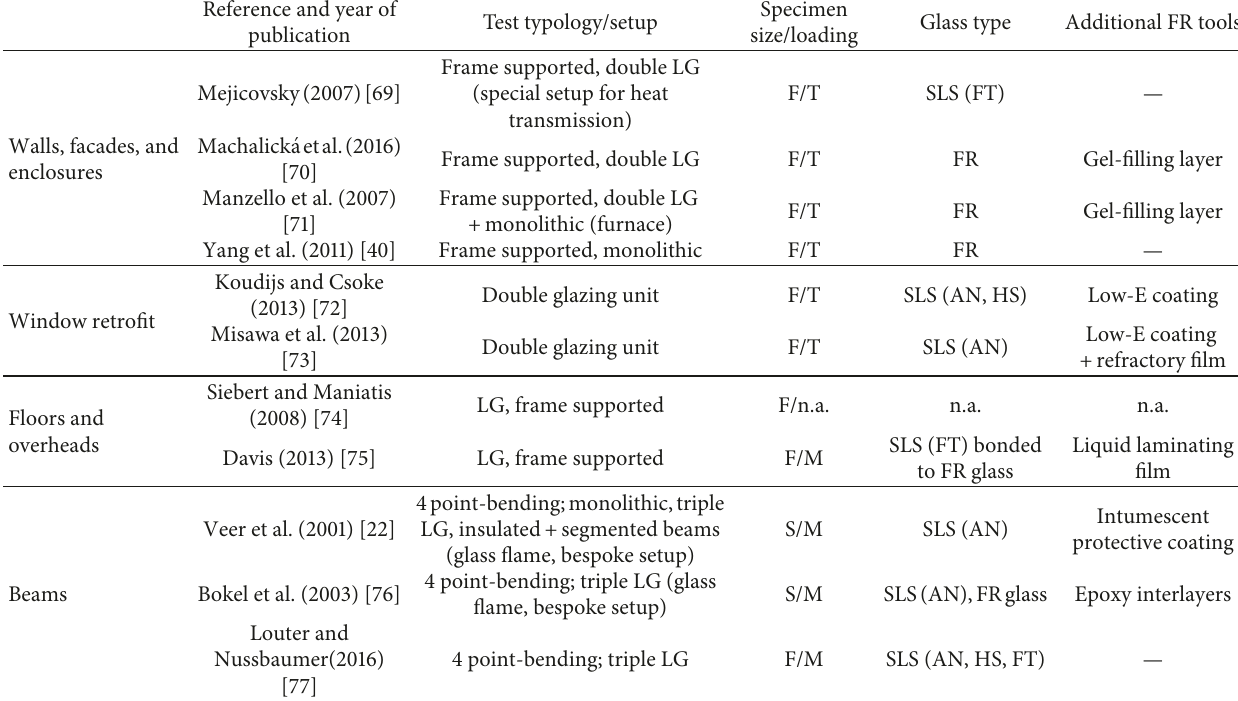
Table 2: Summary of selected experimental research studies on structural glass systems under fire.